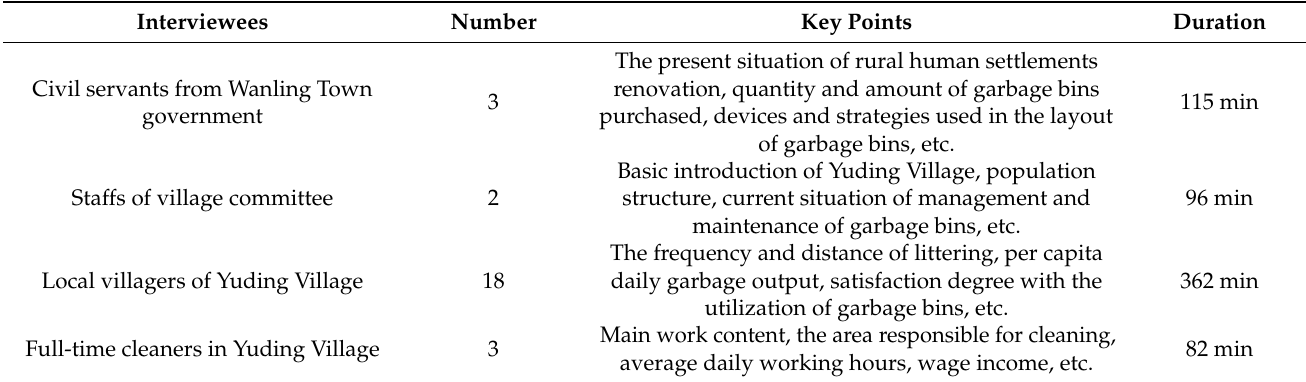
Table 1. Interviewees and key